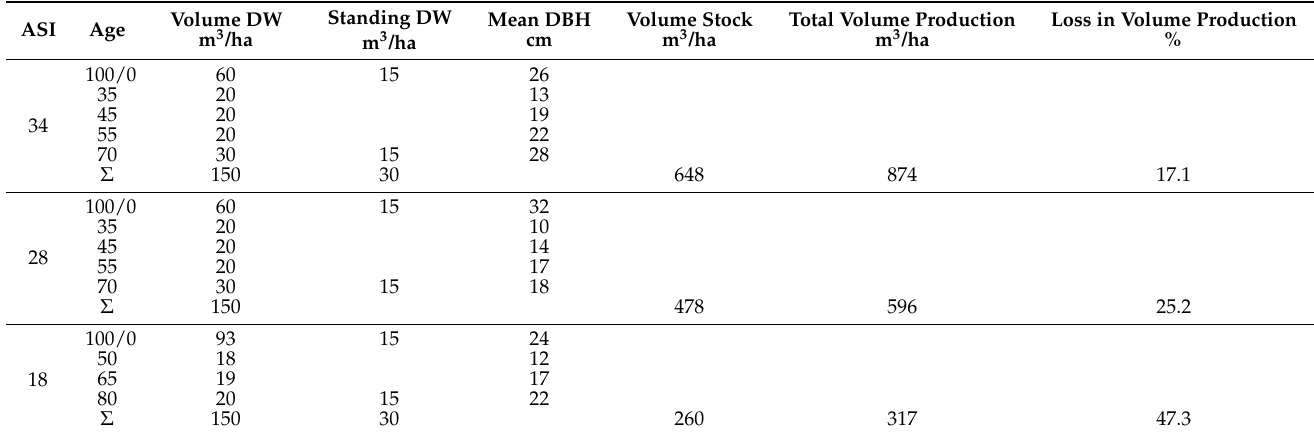
Table 4. Design of active deadwood (DW) management for European beech.